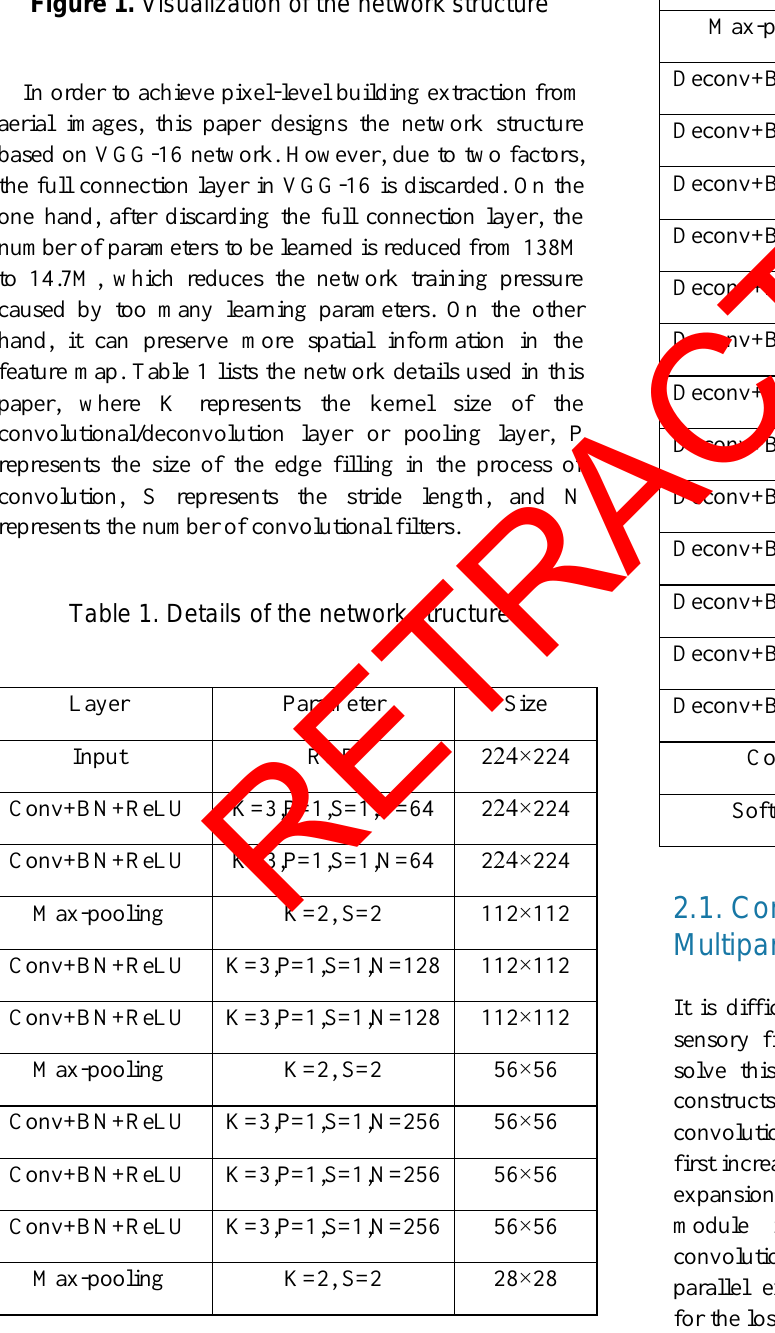
Figure 1. Visualization of the network structure